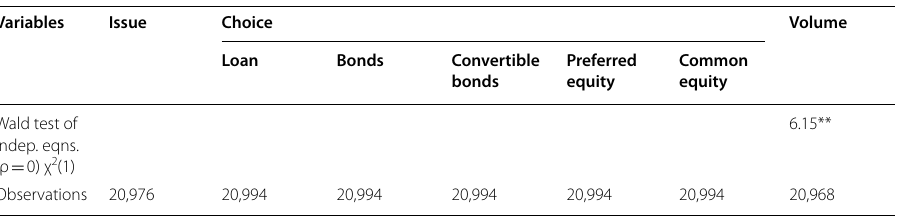
The model includes firm-fixed effects and year-fixed effects and robust standard errors. The sample includes data from 6834 publiclylisted firms in the US. The sample period is from 2000 until 2018. Firms’ decisions follow the sequence shown in Fig. 1. The first decision on issuance is represented by the binary dependent variable Issue . The Choice columns indicates a firm’s choice of instrument without any order. The selectivity bias variables indicate the presence of sample selection bias. The selectivity bias (Eq. 3) estimates are for separate variables for each Choice category but are shown in a single row for brevity. Ρ indicates the correlation between error terms in output and participation equations. Probability of coefficient estimates from the model greater than standard statistics are provided in parentheses with *** p < 0.01, ** p < 0.05, * p < 0.1***. Parentheses contain robust standard error estimates. Asterisks correspond to the outcome of the z-test from the model. Year fixed-effects and firm fixed-effects are included; however, the estimated coefficients are not reported (Long tables are available upon request). Variable definitions are given in “Appendix